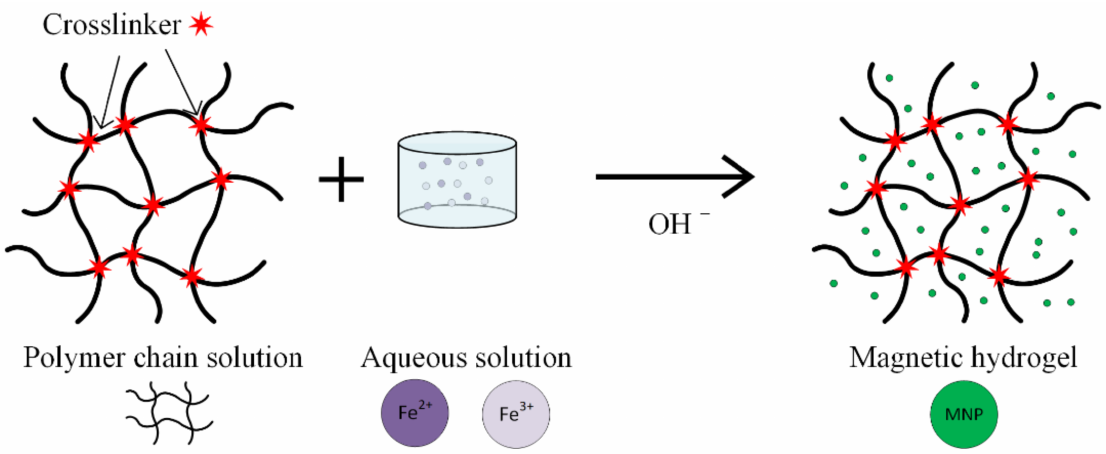
Figure 9. Schematic representation of the in situ co-precipitation method used to prepare a magnetic